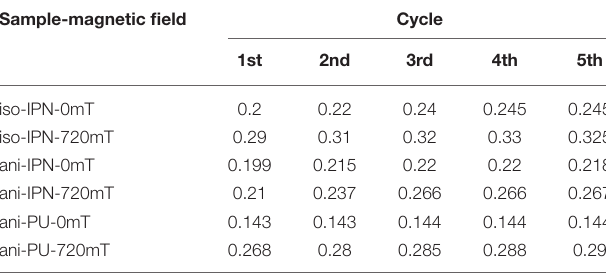
TABLE 3 | G ′ ∞ (MPa) of the samples in the different cycles.